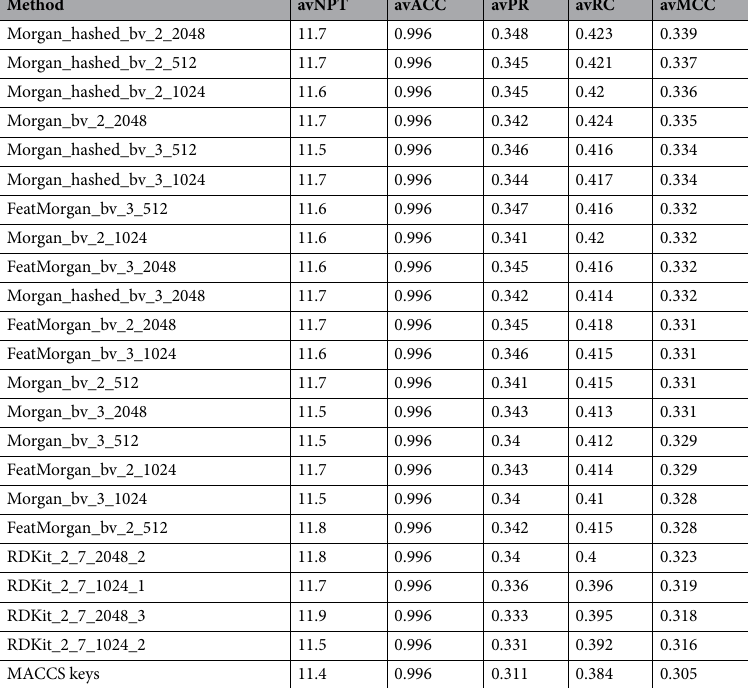
Table 2. Performance of the tested ligand-centric methods averaged over query molecules sorted by descending avMCC value. Each method is named after the employed fingerprint, as the remaining components are common to all